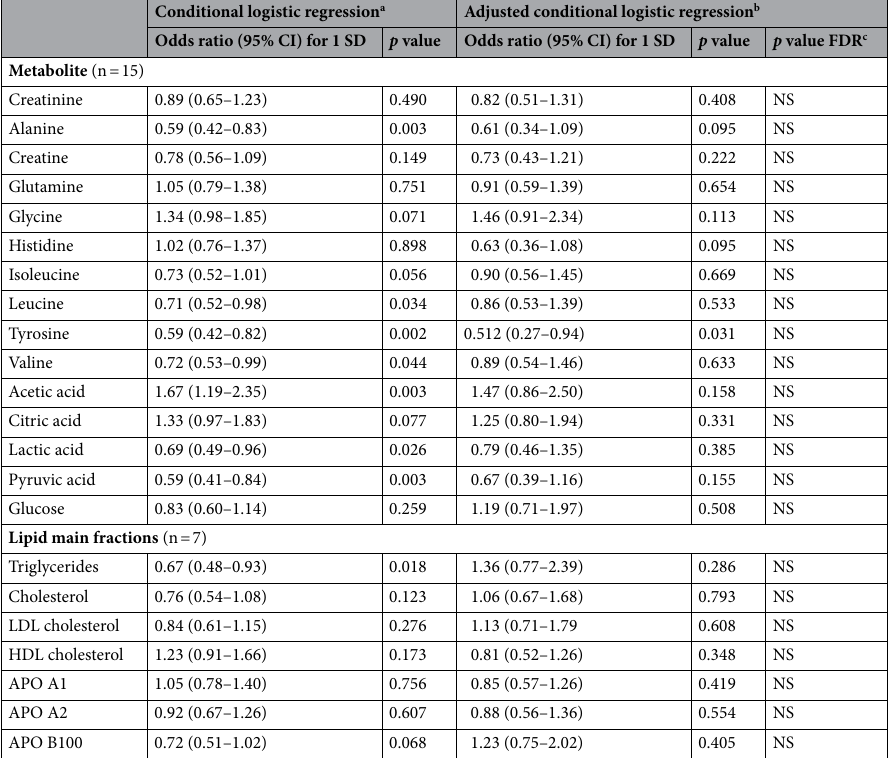
Table 2. Association between metabolites concentration, lipid main fractions concentration and high-MBD BC cases, compared to low-MBD BC cases, in the 87 sets (EPIC Florence, low- vs high-MBD BC case–case study). a Odds ratios per standard deviation (SD) increase in metabolite concentration conditioned on age at cohort entry (± 5 years), type of mammographic examination (analogical/digital; negative/diagnostic) and year of mammographic examination (before/after 2000). Single metabolites and lipid main fractions separately added to the regression model. b Odds ratios per standard deviation (SD) increase in metabolite concentration conditioned on age at cohort entry (± 5 years), type of mammographic examination (analogical/digital; negative/diagnostic) and year of mammographic examination (before/after 2000) and adjusted for age at diagnosis, number of full-term pregnancies, breastfeeding (yes/no), menopausal status at baseline, ER status, body mass index at baseline. Single metabolites and lipid main fractions separately added to the regression model. c p values adjusted for false discovery rate (FDR) at α = 0,05 with Benjamini–Hochberg